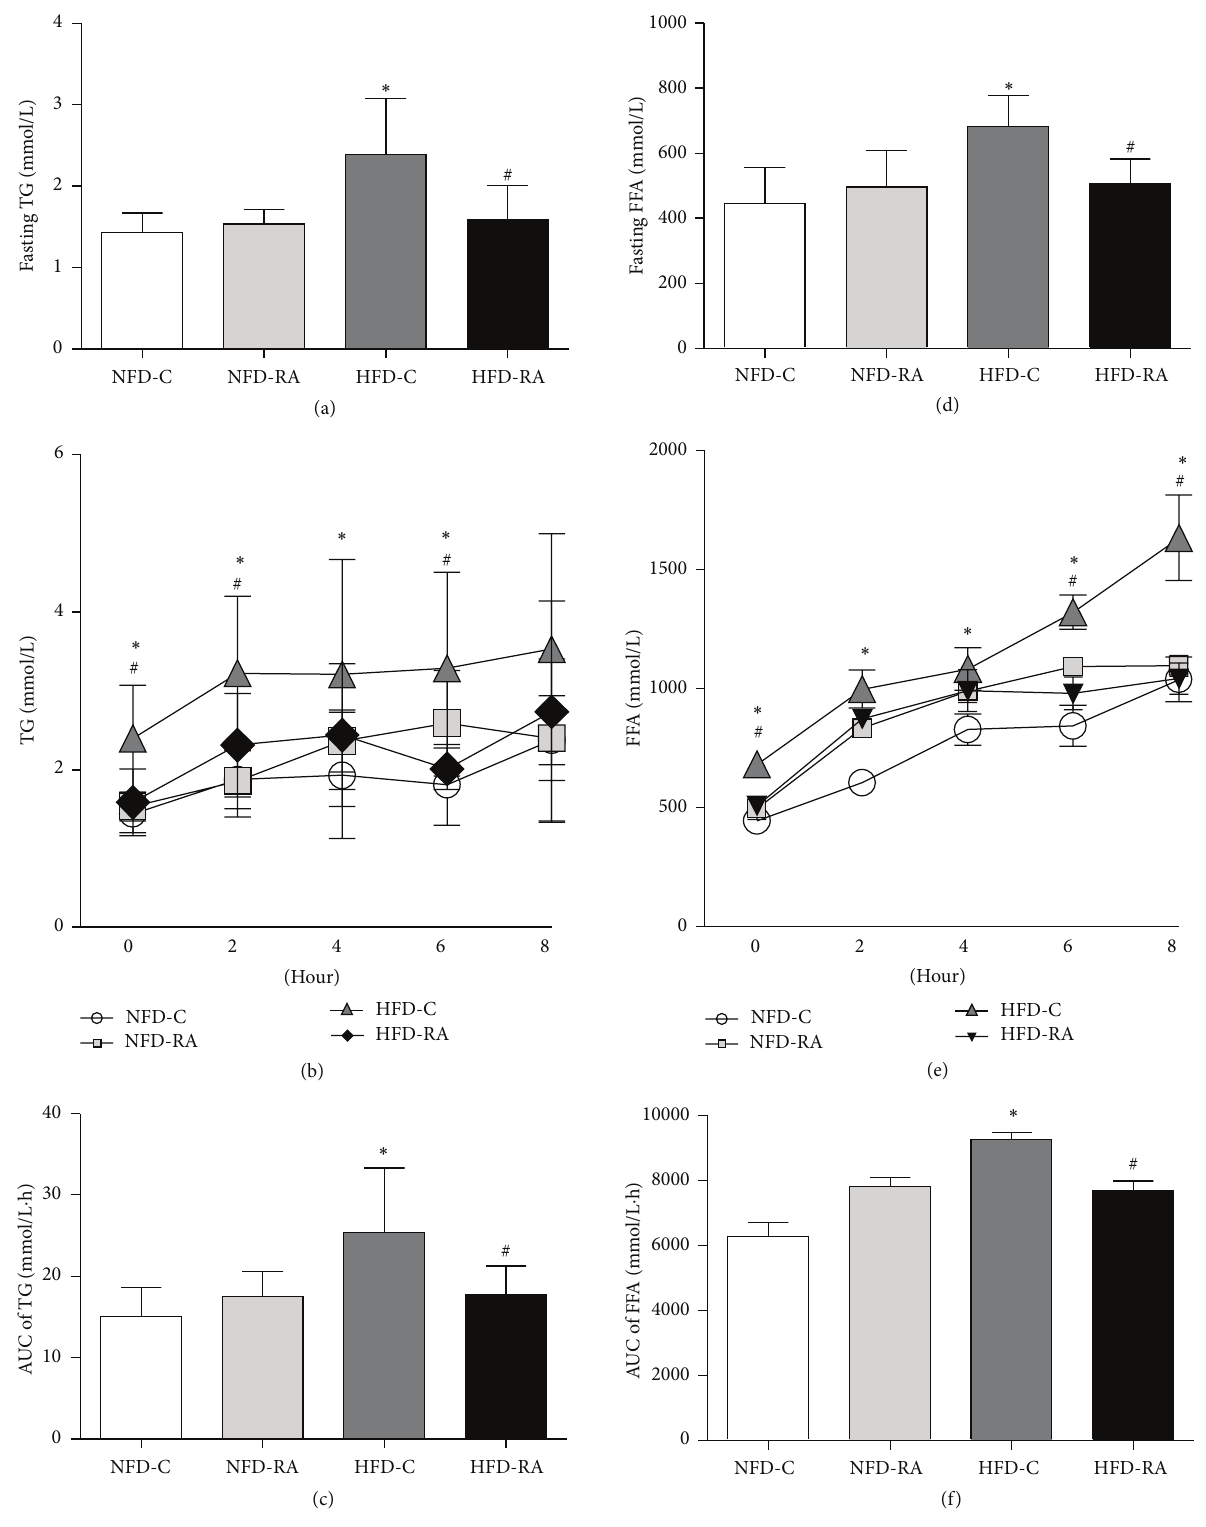
Figure2: RAtreatment decreases TGand FFAlevels aftera 5-hourfastand oliveoilgavage. (a)TGconcentrations inratsintheNFD-C,NFD- RA, HFD-C, and HFD-RA groups after a 5-hour fast ( 𝑛 = 5 –8/group). (b) TG concentrations in rats in the NFD-C, NFD-RA, HFD-C, and HFD-RA groups after olive oil gavage ( 𝑛 = 5 –8/group). (c) The AUC of TG levels during olive oil challenge is shown. (d) FFA concentrations in rats in the NFD-C, NFD-RA, HFD-C, and HFD-RA groups after a 5-hour fast ( 𝑛 = 5 –8/group). (e) FFA concentrations in rats in the NFD-C, NFD-RA, HFD-C, and HFD-RA groups after olive oil gavage ( 𝑛 = 5 –8/group). (f) AUC of FFA levels during olive oil challenge is shown. ∗ 𝑃 < 0.05 (HFD-C group versus NFD-C group) and # 𝑃 < 0.05 (HFD-RA group versus HFD-C